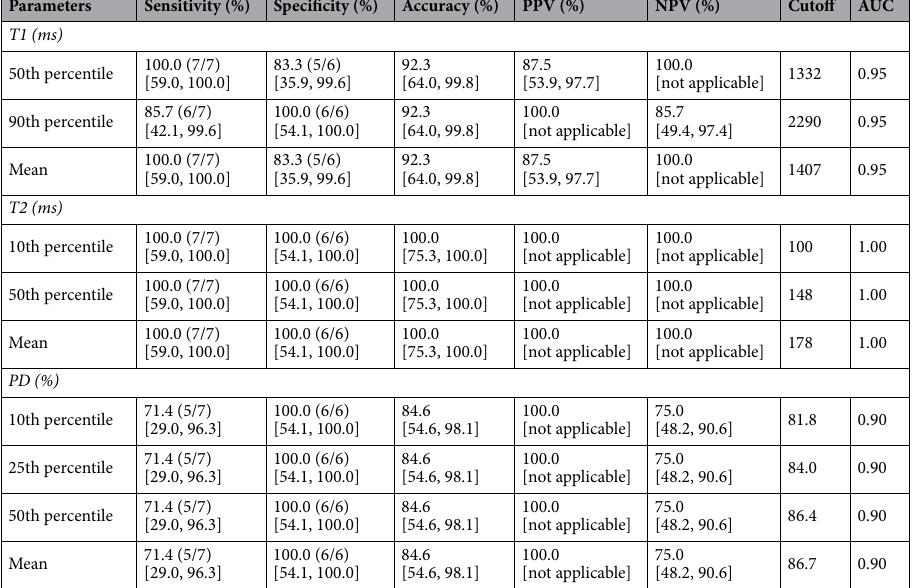
Table 3. The entire set of our results is shown in Supplementary Table S2. The two types of diffuse gliomas could be differentiated using a cutoff value of 178 ms for the T2 relaxation time parameter with 100% sensitivity, 100% specificity, 100% accuracy, and 100% PPV and NPV, with an area under the curve (AUC) of 1.00. Figures 3 and 4 show representative images of patients with astrocytoma and oligodendroglioma, respectively.